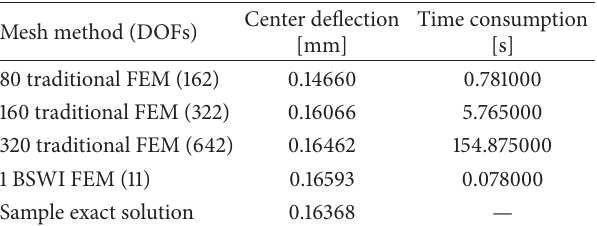
Table 2: Comparison of center deflection of clamp supported beam under uniform load (stochastic